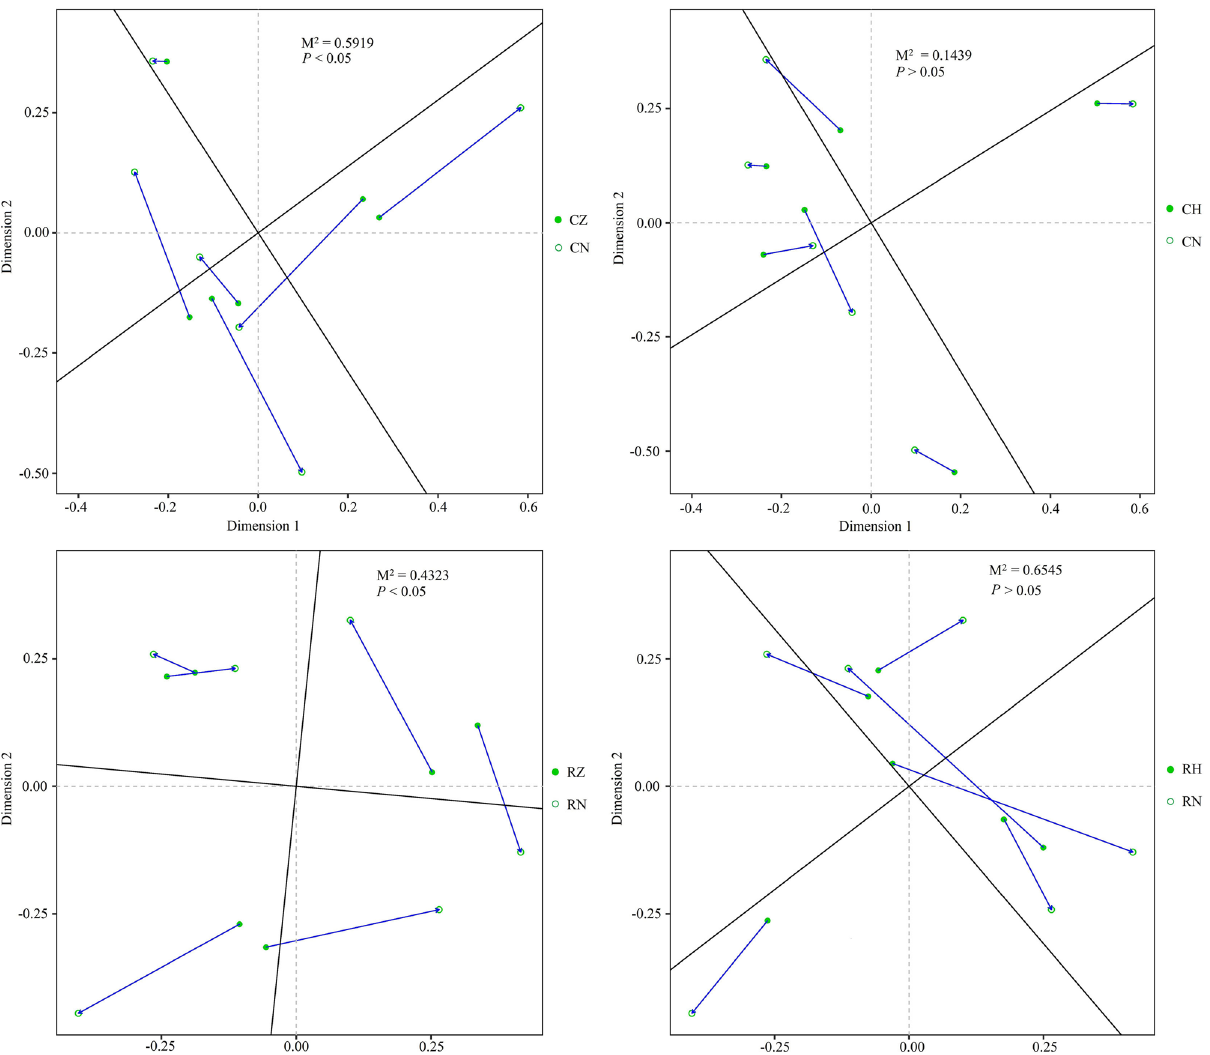
Figure 5. Procrustes analysis of bacterial community among different groups based on Bray–Curtis dissimilarity